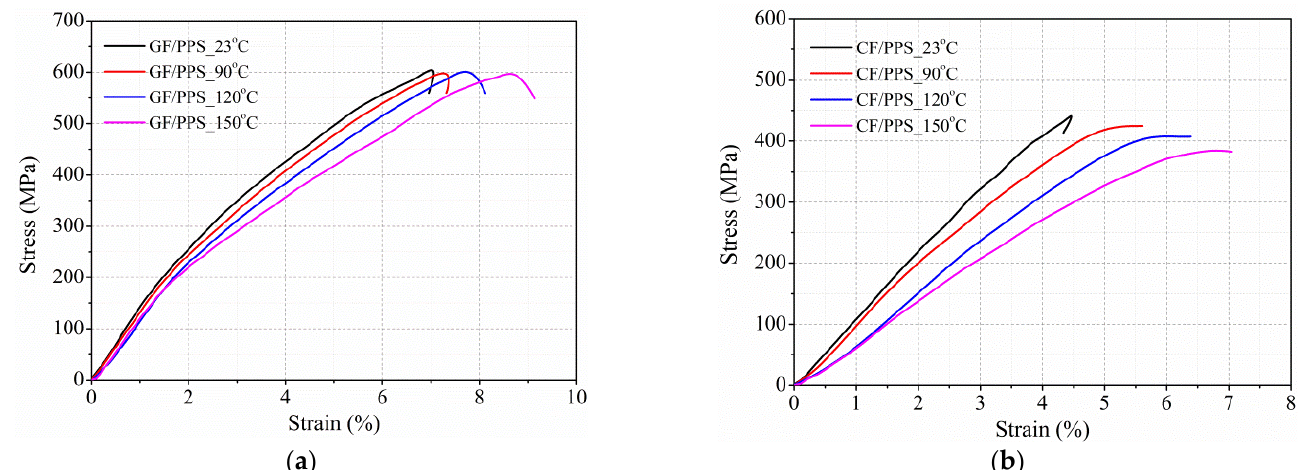
Figure 6. Stress–strain curves of composites under out-of-plane loading at different temperatures. ( a ) GF/PPS and ( b ) CF/PPS specimens.